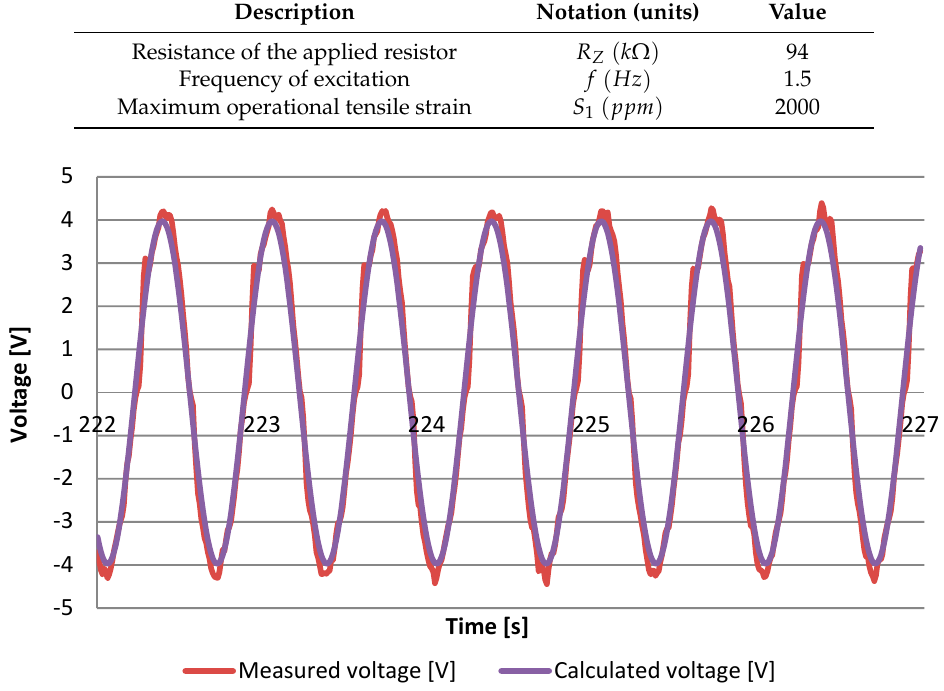
Figure 3. The analytically calculated voltage drop on the resistor and the course recorded during measurements at the laboratory stand at 20 °C.